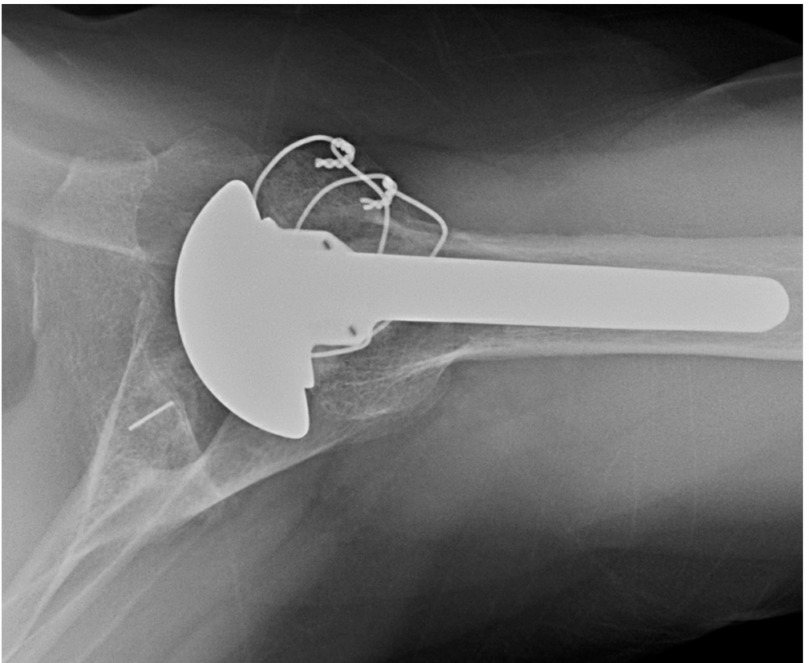
Figure 3. Anatomic TSA with posteriorly augmented glenoid polyethylene. Axillary X-ray of posteriorly augmented glenoid